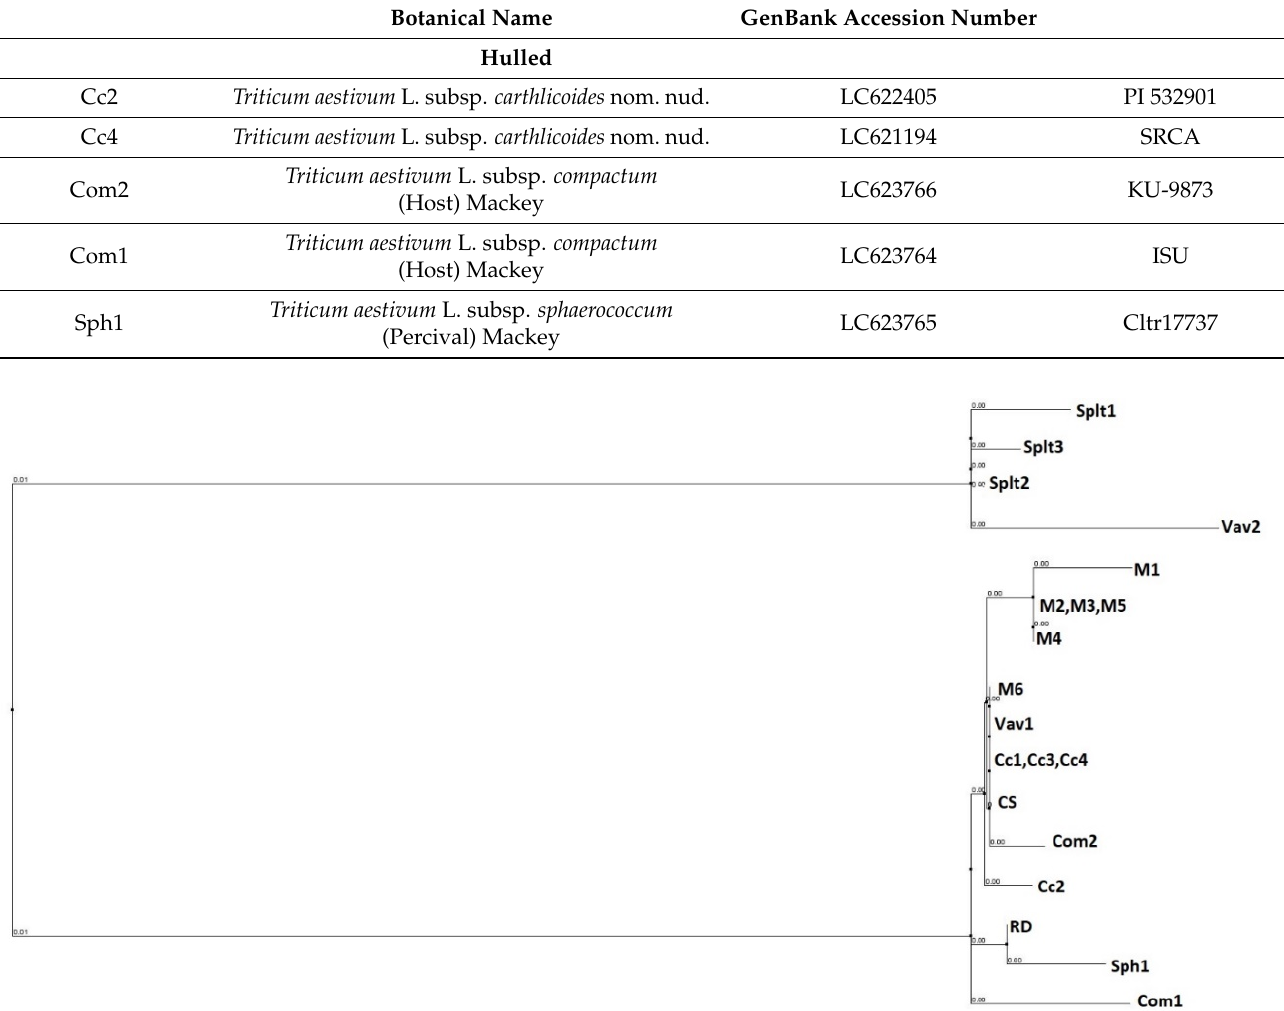
Figure 1. Complete chloroplast genome phylogeny of hexaploid wheats.